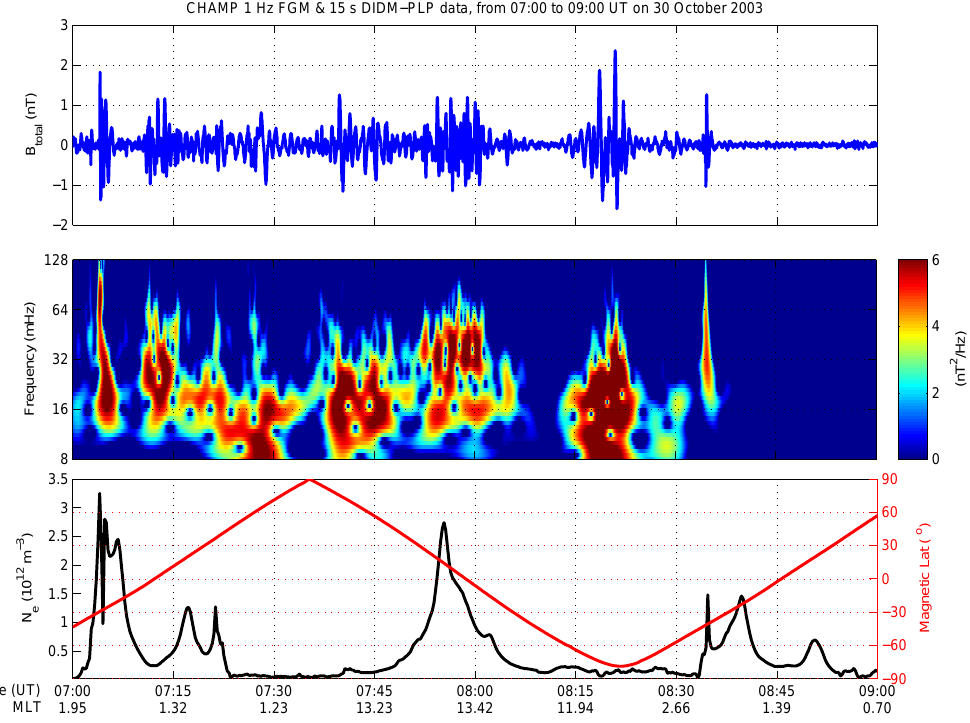
Fig. 6. Event 1: 07:00–09:00UT, 30 October 2003. As in Fig. 3 but for a longer time period (i.e., two hours instead of the ∼ 45min duration of the LEO